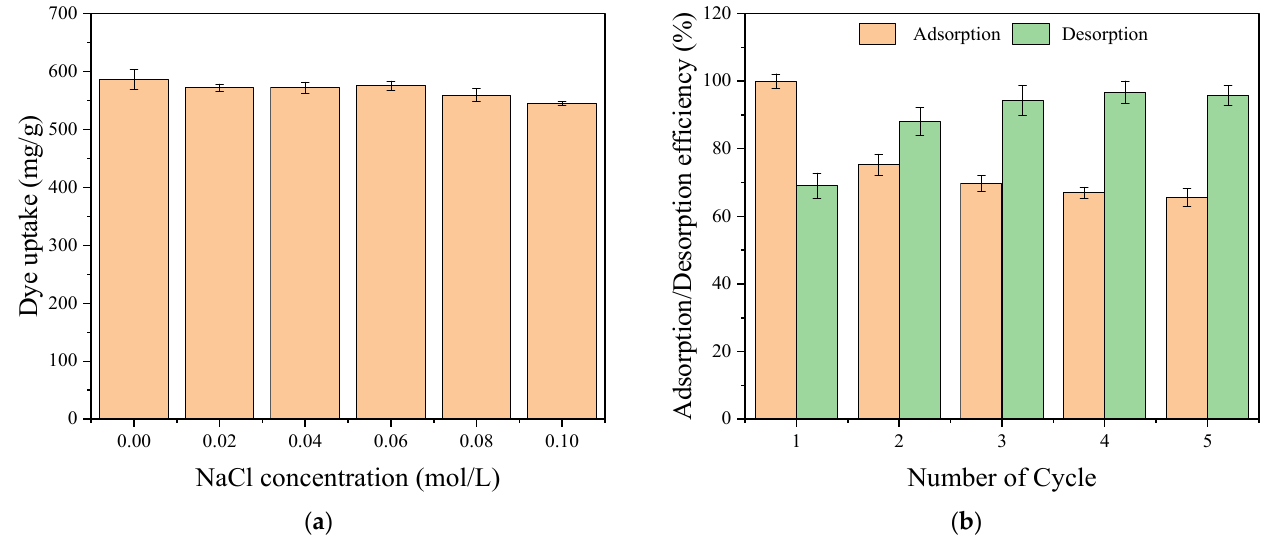
Figure 9. ( a ) Effect of ionic strength on RY2 adsorption by PEI/APTES-MWCNTs; ( b ) adsorption/desorption efficiencies of PEI/APTES-MWCNTs for RY2 removal.